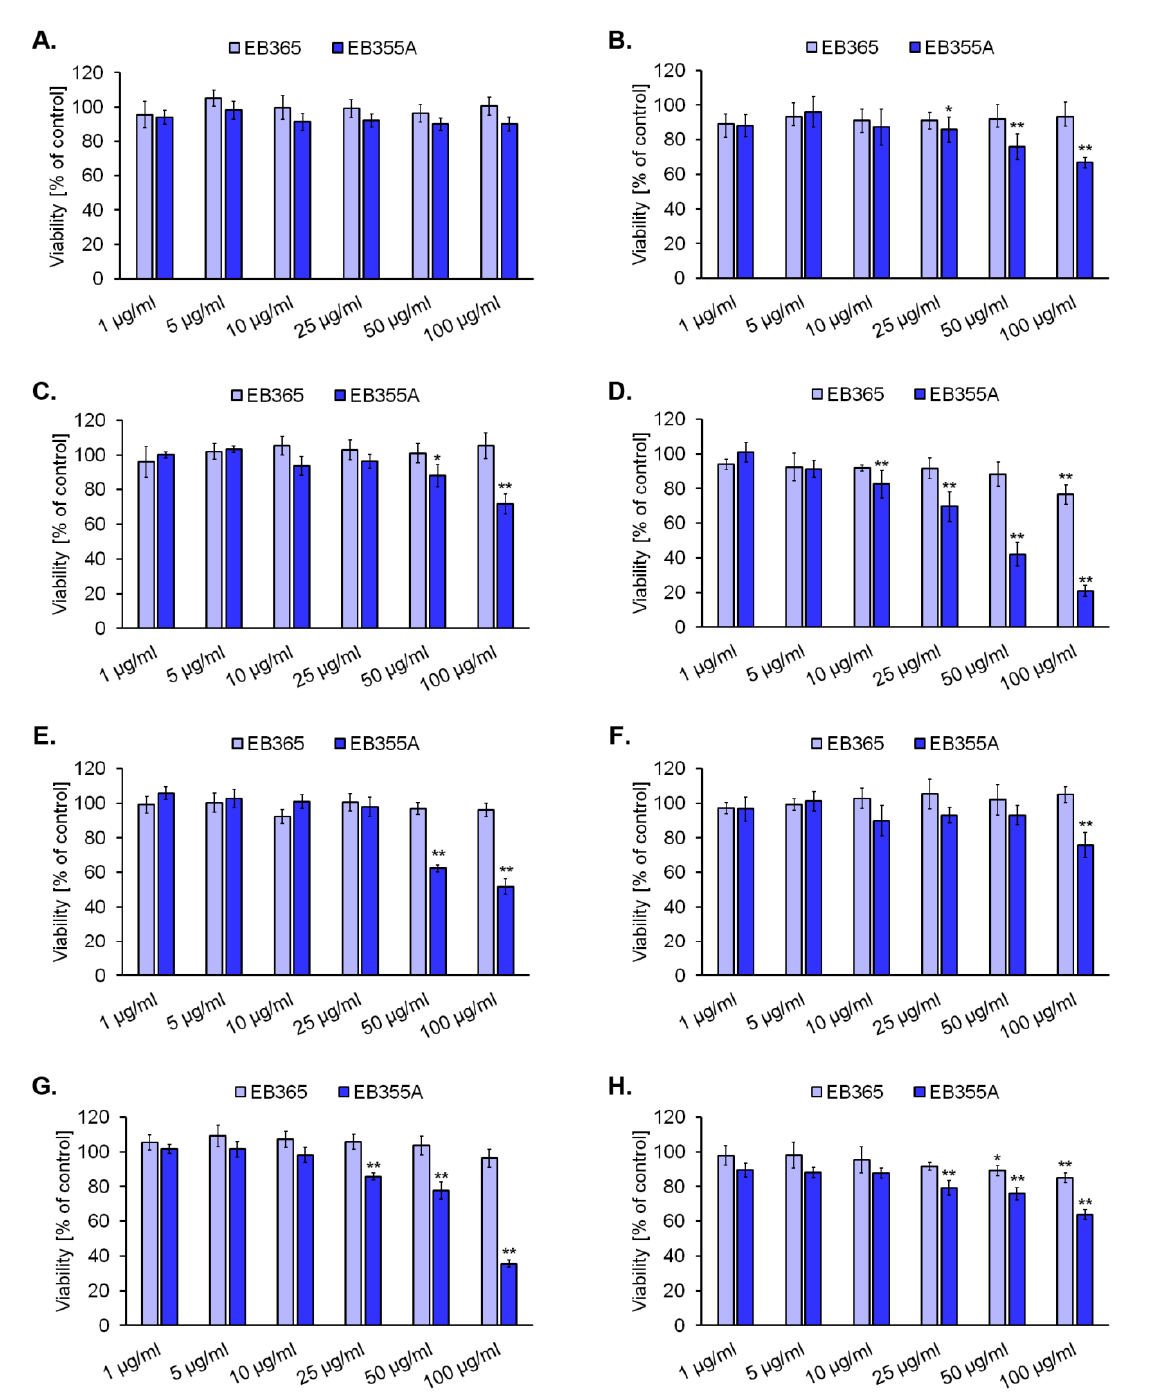
Figure 3. The impact of the novel indole-functionalized betulin derivatives EB365 and EB355A on the viability of normal human fibroblasts ( A ), lung carcinoma A549 cells ( B ), breast cancer MDA-MB-231 ( C ) and MCF-7 cells ( D ), colorectal adenocarcinoma DLD-1 ( E ) and HT-29 cells ( F ), melanoma A375 ( G ) and C32 cells ( H ). The cells were treated with the compounds at concentrations ranging from 1 to 100 µg/mL for 72 h and then analyzed using a WST-1 assay. The results were normalized to the control values, which were set to 100%. Graphs represent the mean ± standard deviation of 3 independent experiments. * p < 0.05, ** p < 0.01 vs. control.